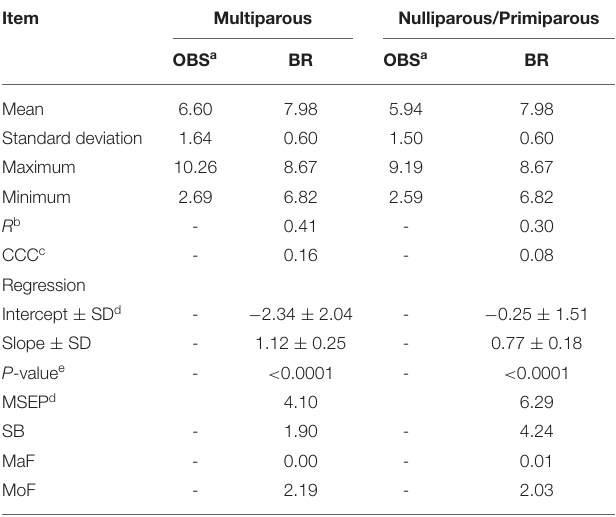
TABLE 3 | Mean (kg) and descriptive statistics of the relationship among the observed and predicted values of milk production of Nellore cows according to parity